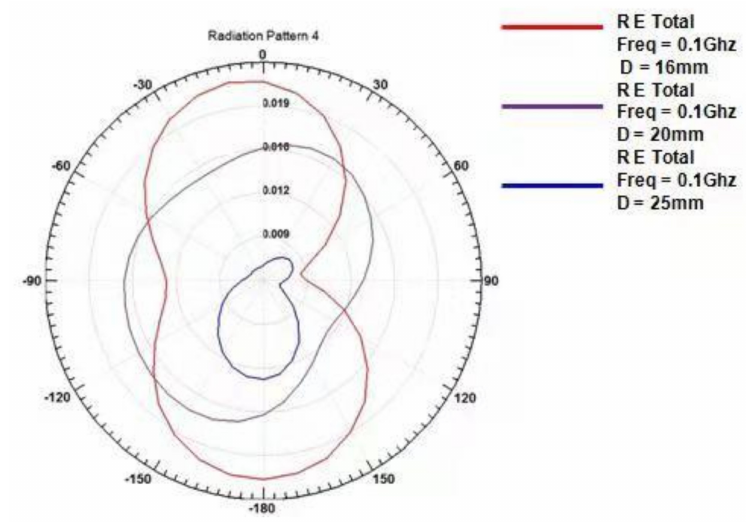
Figure 10. Magnetic field radiation patterns with unit spacings of D = 16, 20, and 25 mm.